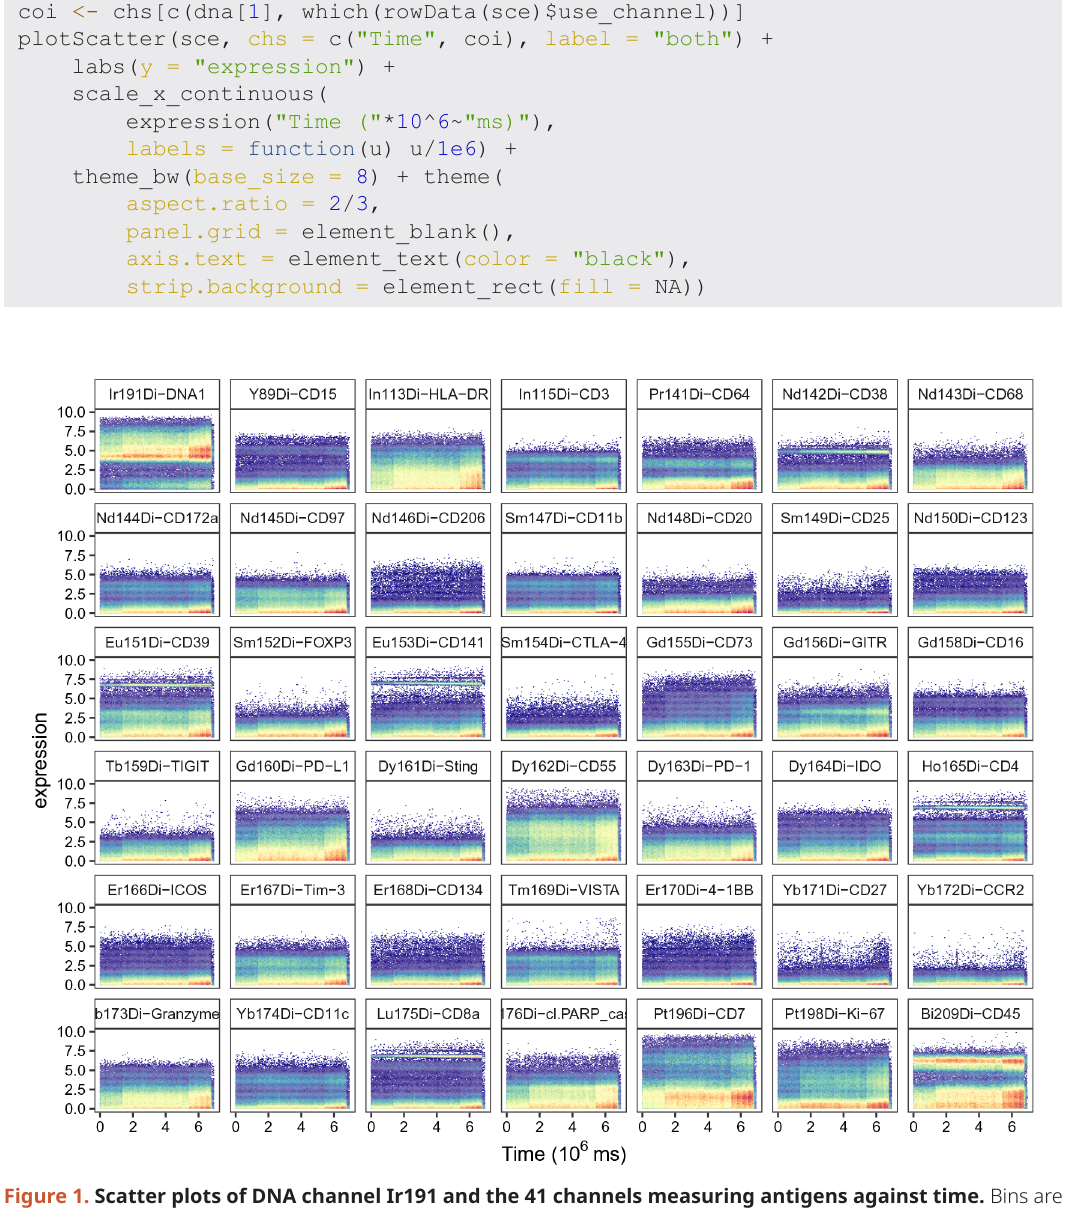
Figure 1. Scatter plots of DNA channel Ir191 and the 41 channels measuring antigens against time. Bins are colored by cell density; y-axis corresponds to cofactor-5 arcsinh-transformed dual